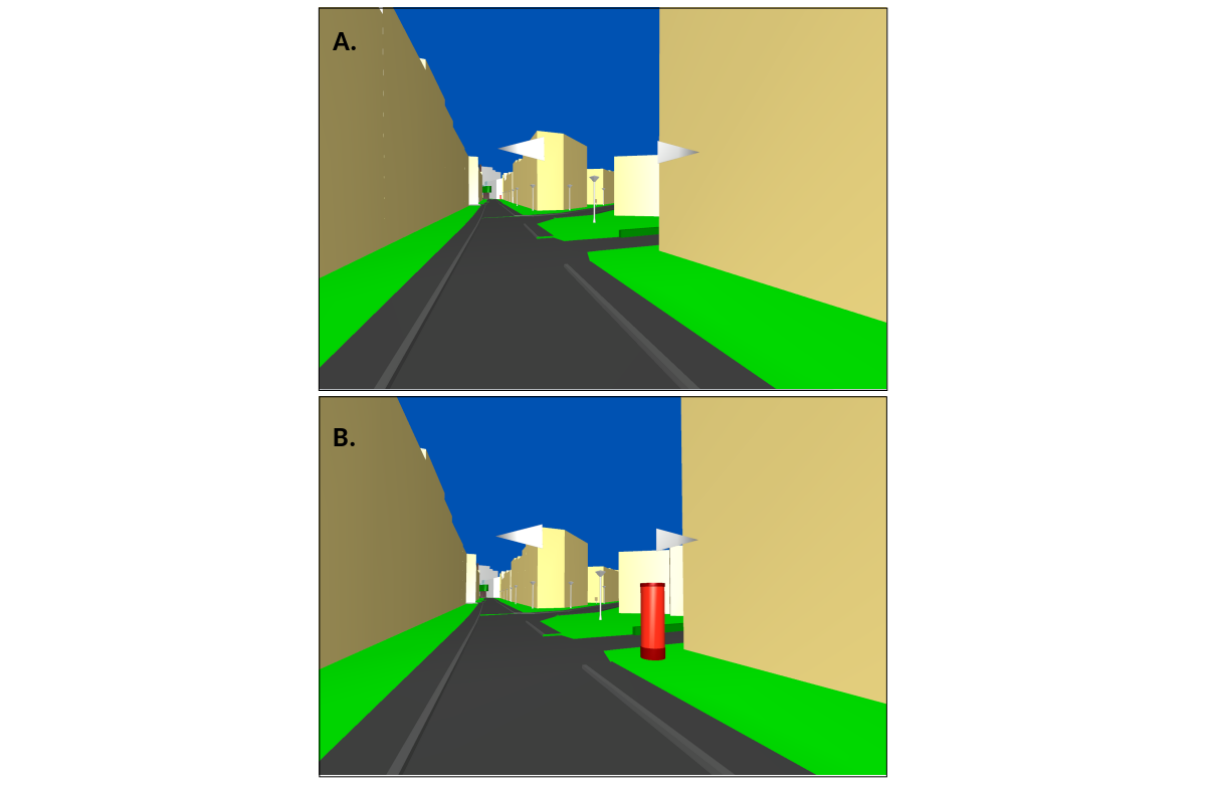
Figure 4. Example of changes in the environment to induce disorientation. (A) Original environment shown in the guided walk (note the red landmark at the far end of the road, to the right). (B) Manipulated environment used in the experimental run; in this case, the landmark is moved to a different